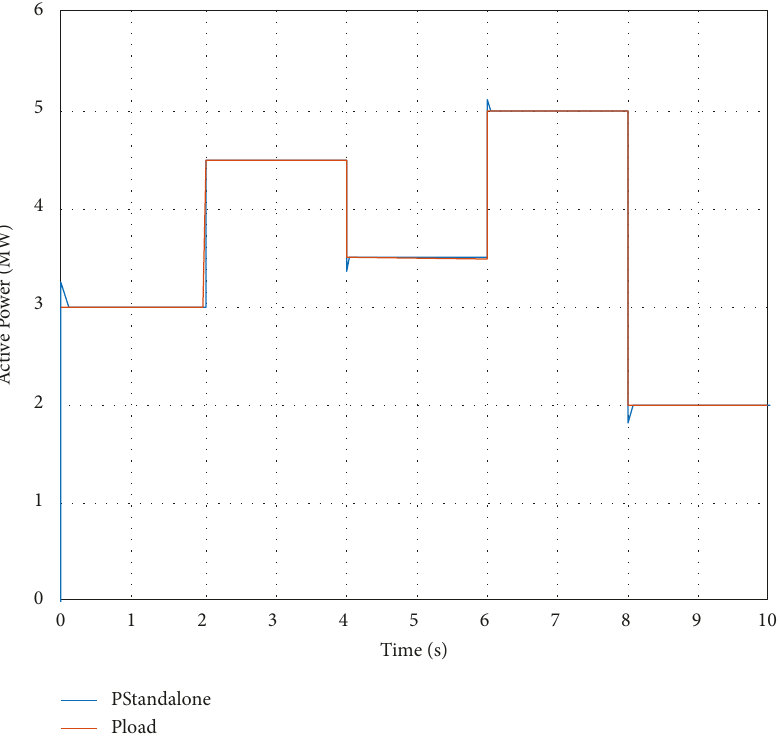
Figure 16: Dynamic performance analysis of the standalone system.